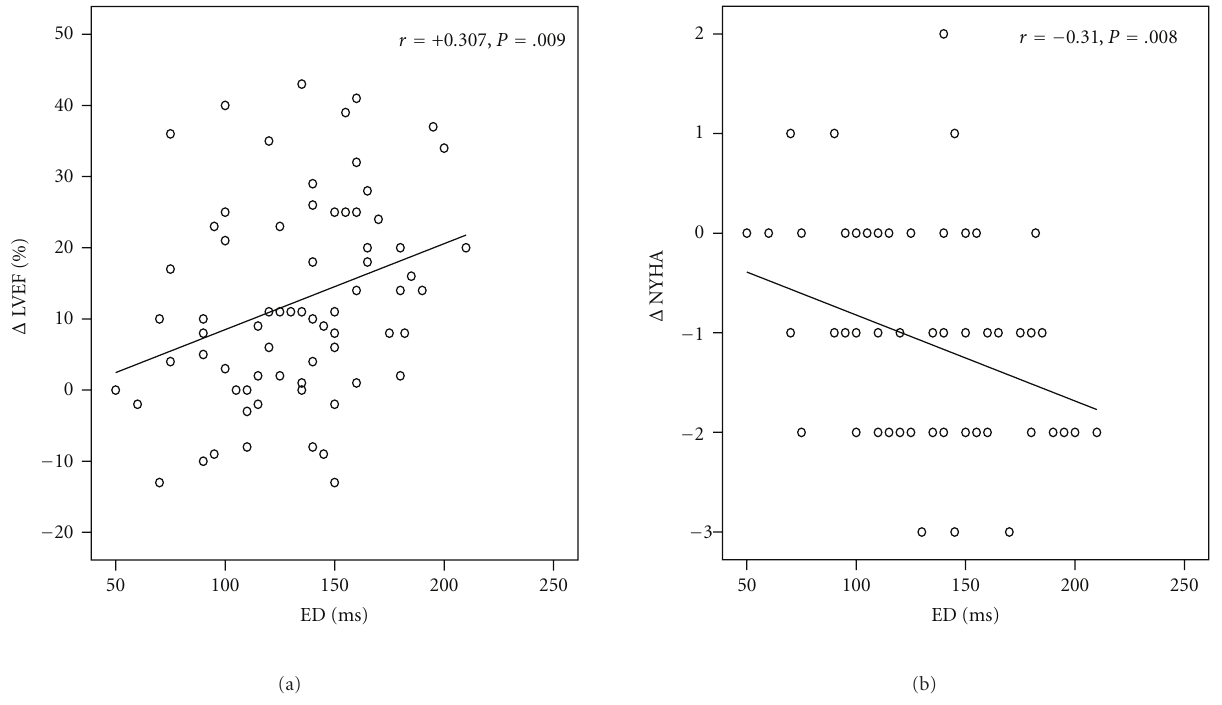
Figure 2: Correlation between ED and Δ LVEF (a) and Δ NYHA class (b). Abbreviations: ED: electrical delay, Δ LVEF: di ff erence of LVEF between long-term followup and baseline, Δ NYHA: di ff erence of NYHA class between long-term followup and baseline.